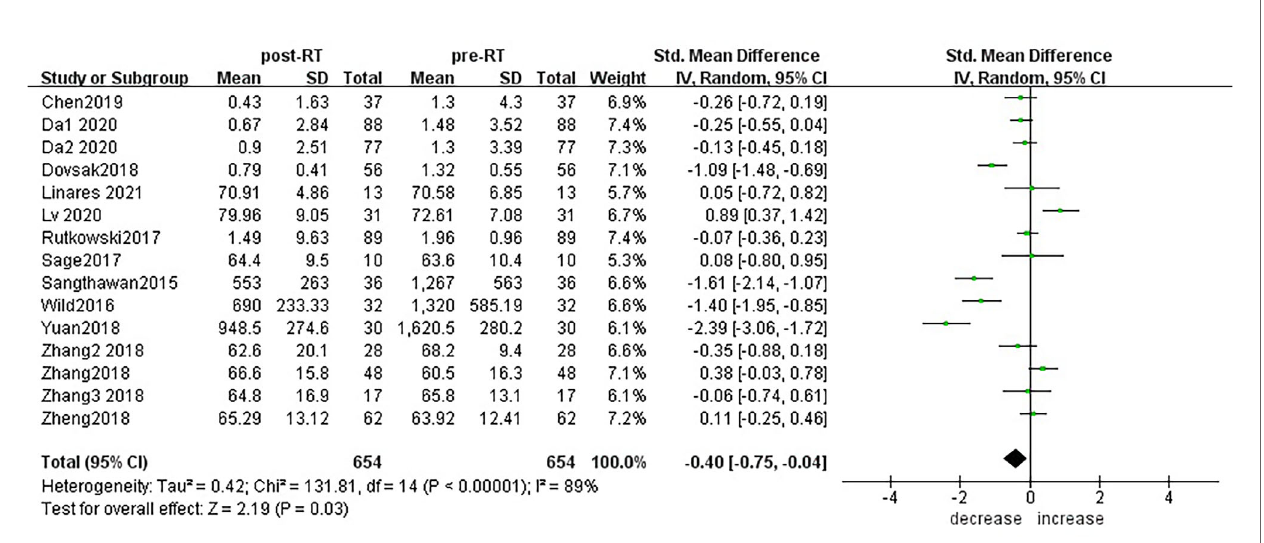
FIGURE 2 | Forest plot for changes of CD3+T lymphocytes after radiotherapy compared with before radiotherapy. decrease: CD3+T lymphocytes were less after radiotherapy than before. increase: CD3+T lymphocytes were increased after radiotherapy than before. Data are presented as standard mean difference [SMD] and 95% CI.